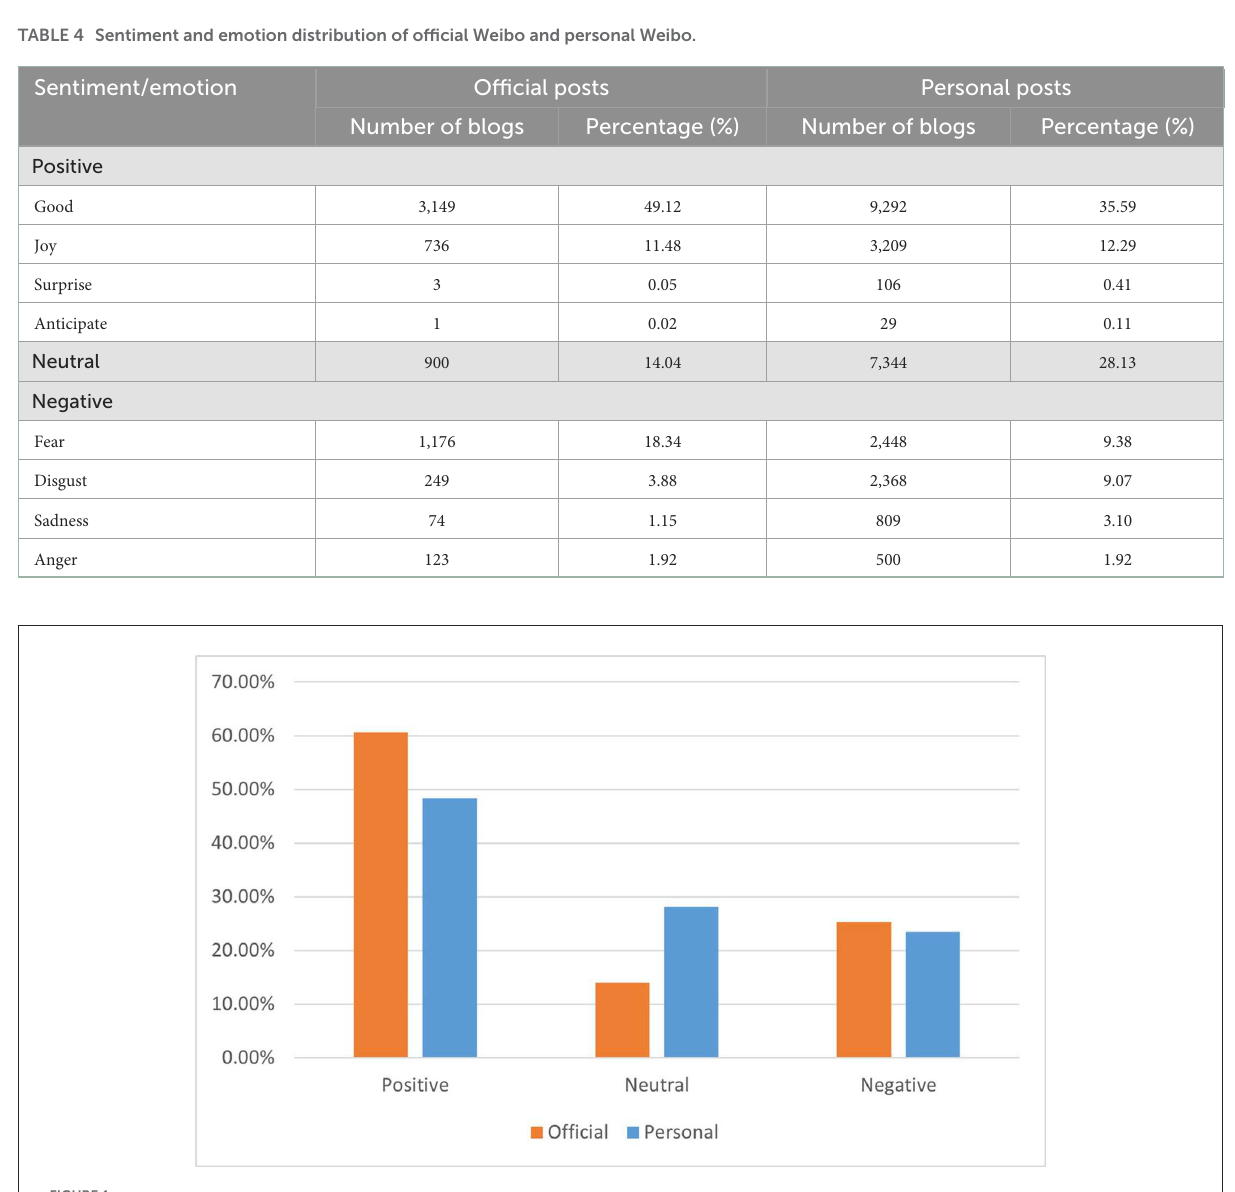
FIGURE1 Comparison of sentiment distribution between official Weibo and personal